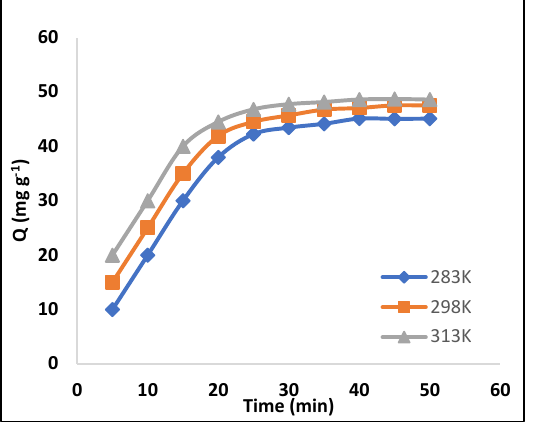
Figure 5. Adsorption kinetics of AB-234 dye in the MIP, polymer mass 8 mg, V = 10 mL, pH = 5, AB-234 = 100 mg/g.